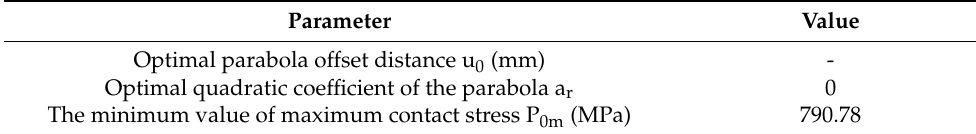
Table 7. Optimization result of the helical face gear without modification.